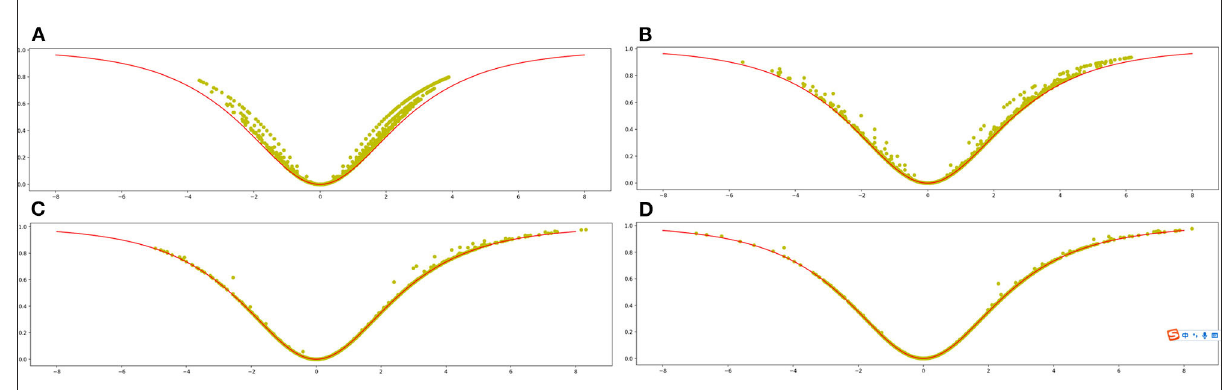
FIGURE1 The relationship between the “bullishness index” and the “agreement index” in a simulation. (A) The simulation for N = 100, while (B) represents the simulation for N = 1,000. (C) The simulation for N = 10,000, while (D) represents the simulation for N =